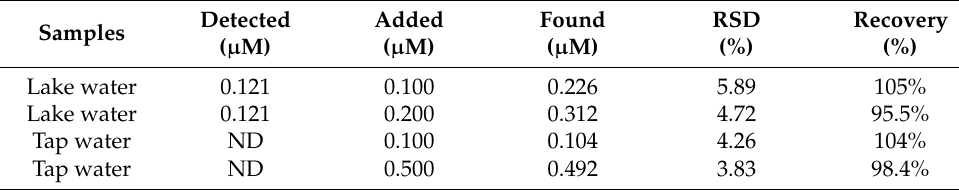
Table 3. Determination of Pb 2+ in the water samples using the Bi 2 O 3 /MnO 2 /GO/GCE composite ( n =